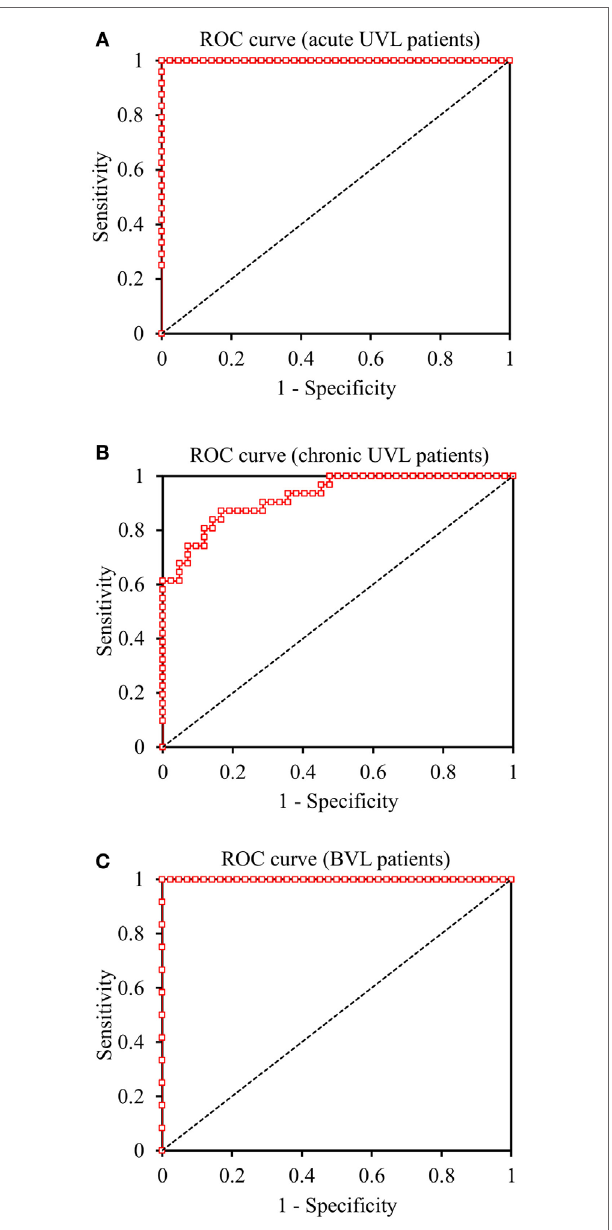
FigUre 7 | receiver Operating characteristic (rOc) curves of shiMP test in the discrimination of acute UVl, chronic UVl, and BVl patients . (a) The ratio between mean peak saccade velocity and mean head-peak velocity in SHIMPs with 1.10 discriminated acute UVL patients from healthy controls with 100% sensitivity and 100% specificity. (B) The ratio with 1.74 discriminated chronic UVL patients from normal subjects with 87% sensitivity and 83% specificity. (c) The ratio with 1.37 discriminated BVL patients from healthy controls with 100% sensitivity and 100%